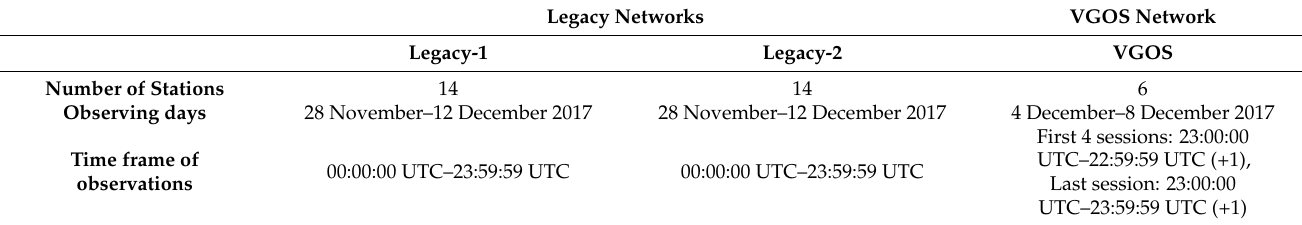
Table 1. Overview of 24 h sessions during CONT17.